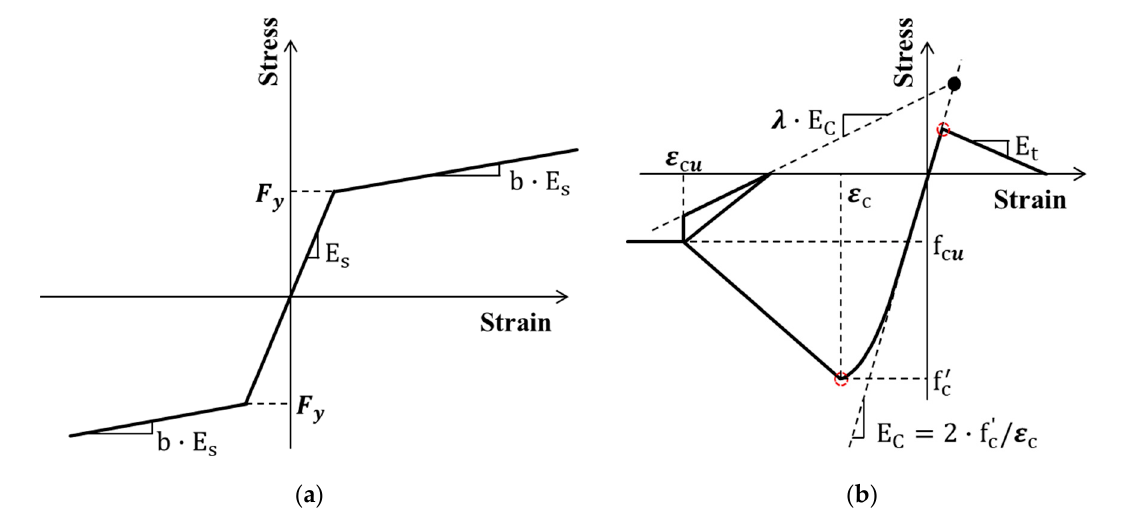
Figure 4. Material constitutive laws in OpenSees [18]: ( a ) Steel01 ; ( b ) Concrete02.